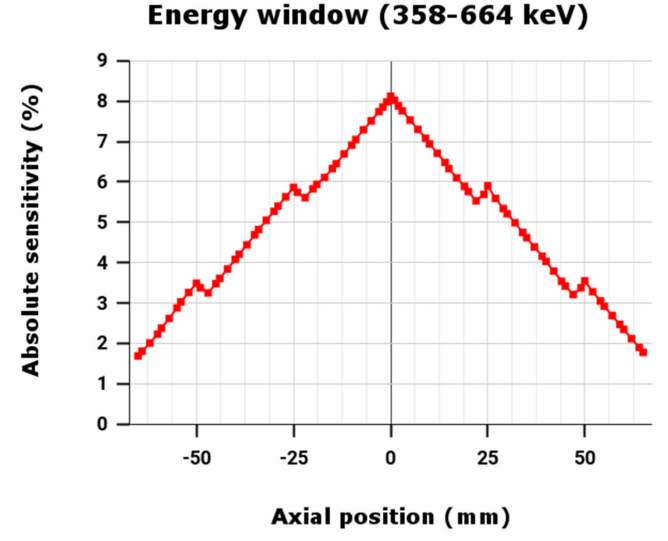
Figure 7. The axial absolute sensitivity profile of the PET/MRI